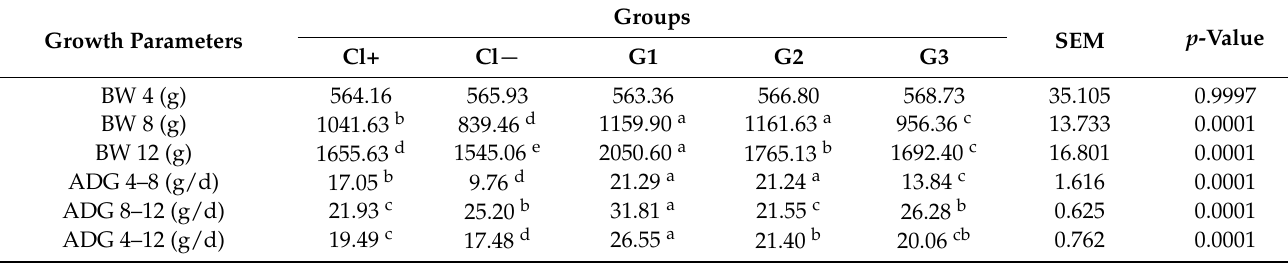
Table 5. Growth performances of rabbits as affected by yogurt groups. All yogurt samples were administered to animals at a dose of 5 g/kg body